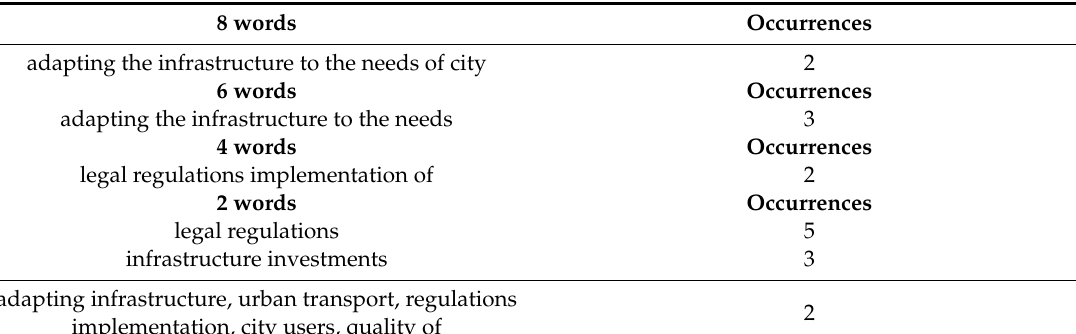
Table A5. Text mining results